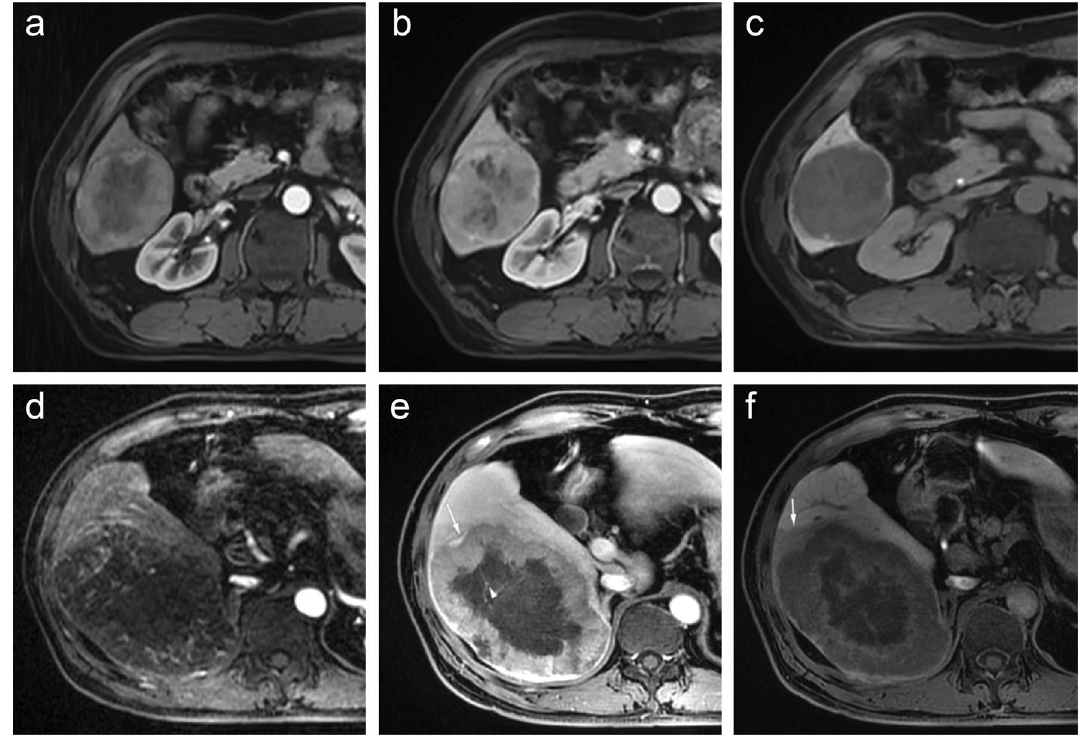
Fig. 4 The representative patients with low risk and high risk of early postoperative recurrence. A 57-year-old woman with a 7.2 cm moderately differentiated HCC in hepatic segment V/VI, serum AFP level of 4.11 ng/mL, ALT level of 33 IU/l and AST level of 23 IU/l was divided into low risk group of Early postoperative recurrence after curative resection. The mass of this patient was a single nodule which showed non-rim hyperenhancement on arterial phase ( a ), no washout on portal venous phase ( b ) and hypointensity on hepatobiliary phase ( c ). This patient did not undergo recurrence during one-year follow up. A 44-year old man, who was identified with high risk of early postoperative recurrence, showed a 13.3 cm poorly differentiated HCC in hepatic segment VI/VII, serum AFP level of 706.5 ng/mL, ALT level of 40 IU/l and AST level